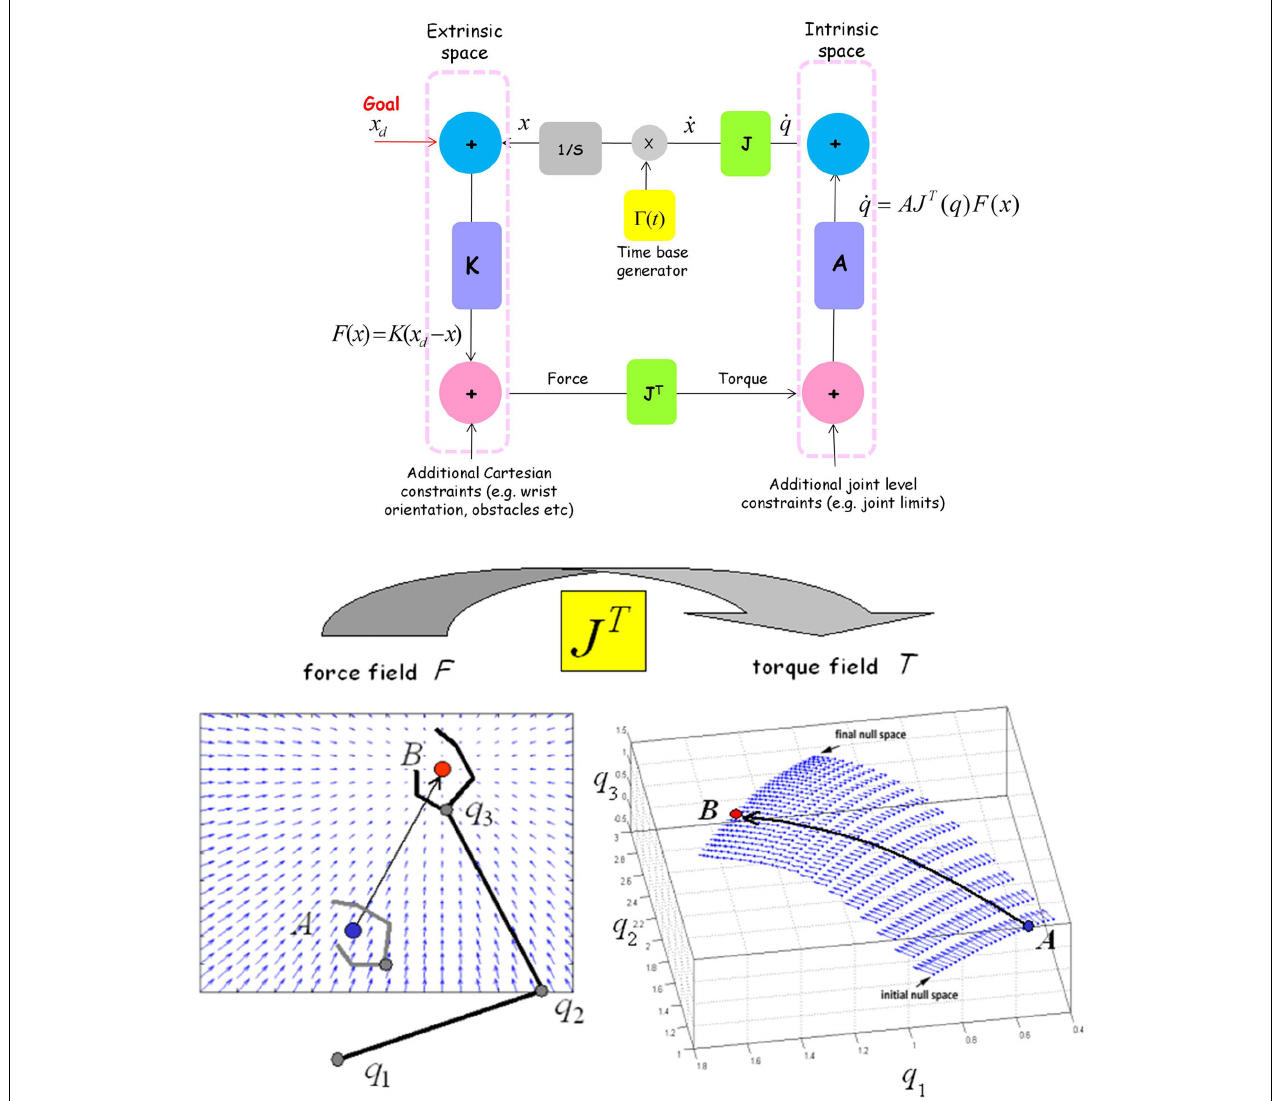
equilibrium in order to take into account suitable “penalty functions.”This is a multi-referential system of action representation and synergy formation, which integrates a Forward and an Inverse Internal Model. Bottom panel. The figure illustrates the key element of the architecture of Figure 1 for solving the degrees of freedom problem, namely the mapping of the “force field,” defined in the extrinsic space and applied to the end-effector, into the corresponding “torque field,” defined in the intrinsic space and applied to the joints.The mapping is implemented by means of the transpose Jacobian matrix of the kinematic transformation. Dimensionality reduction is obtained implicitly by letting the internal model “slide” in the torque field. Each point of the trajectory in the extrinsic space corresponds to a whole manifold in the intrinsic space (the “null space” of the kinematic transformation).The equilibrium point in the force field corresponds to an equilibrium manifold in the torque field.The selection among the infinite number of possible targets is carried out implicitly by the combination of different force/torque